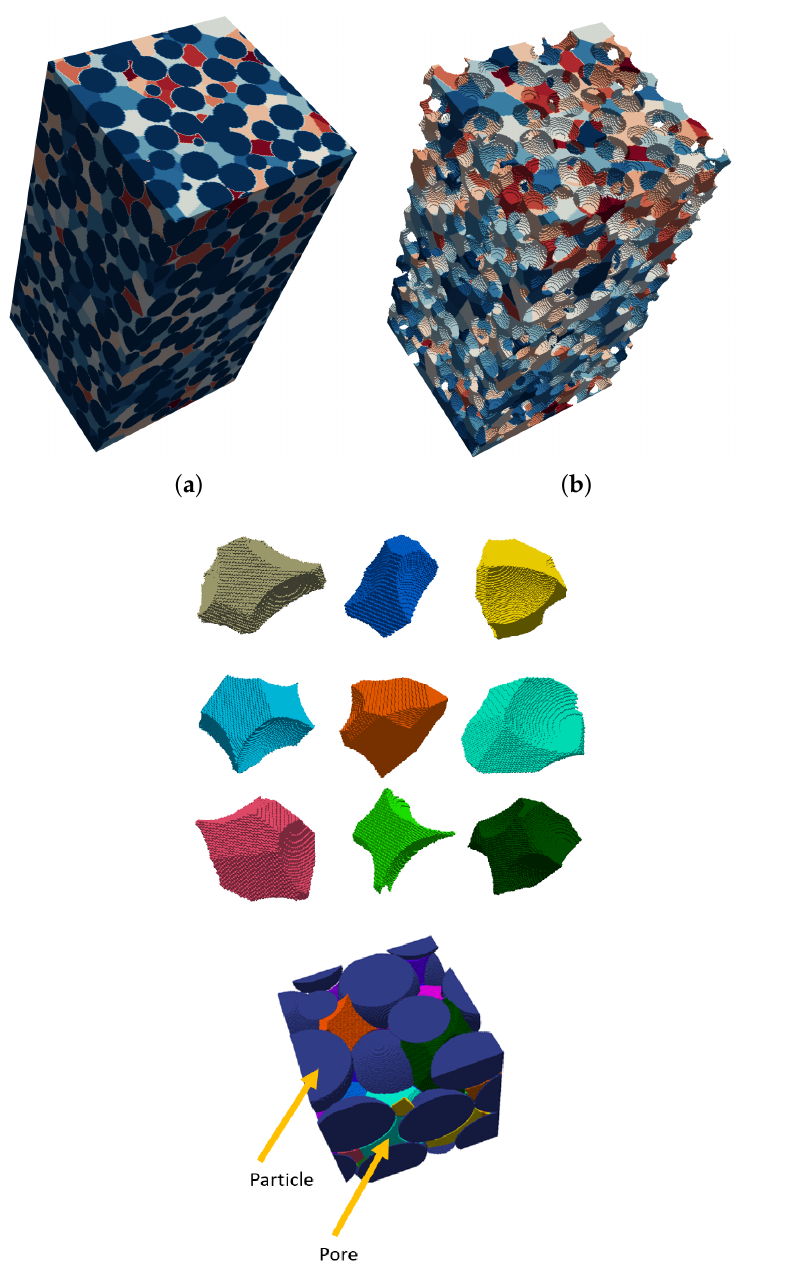
Figure 6. Segmentation result of a very loose mono-sized sphere packing. ( a ) solid and void phases; ( b ) segmented pore space; ( c ) example of extracted local